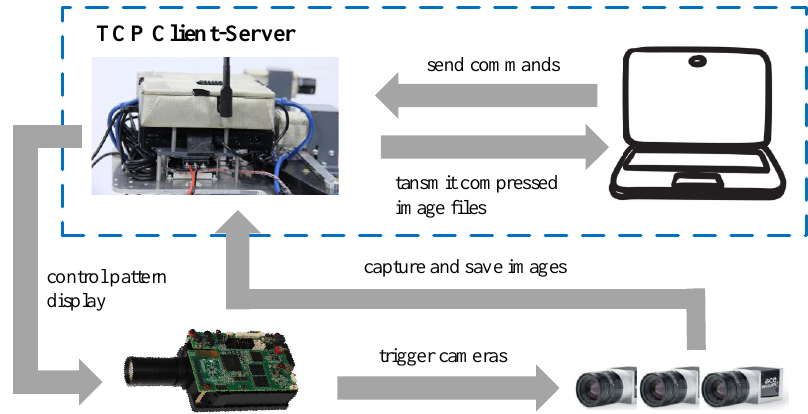
Figure 2. Schematic of image acquisition process. The laptop and the mini-PC constitute a simple client-server architecture using TCP socket programming, thereby enabling the operators to start, pause and stop the synchronous acquisition by pressing corresponding keys. The compressed color image is transmitted back to the laptop for display, based on which the pose of the setup can be adjusted to achieve a better view of